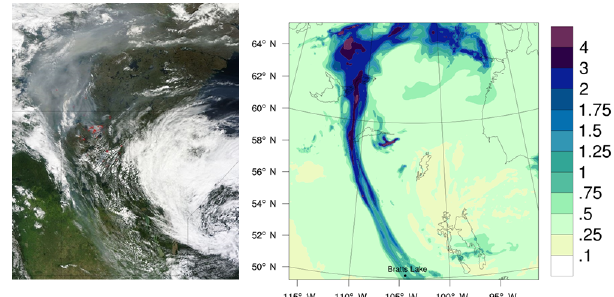
Figure 6. Left: satellite image in the visible section at 17:55UTC, 15 July 2010. The center of the image is located at 56 ◦ N and 102 ◦ E. The red dots denote the fire locations. The gray structures state the distribution of smoke (LANCE Rapid Response MODIS Image Gallery, NASA). Right: simulated aerosol optical depth at 18:00UTC, 15 July